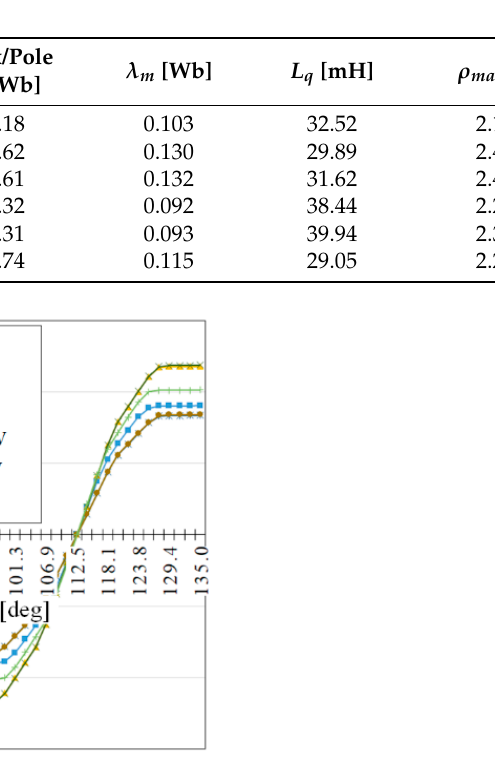
Figure 4. Phase flux linkage as a function of rotor position for the considered magnet arrange- ments.